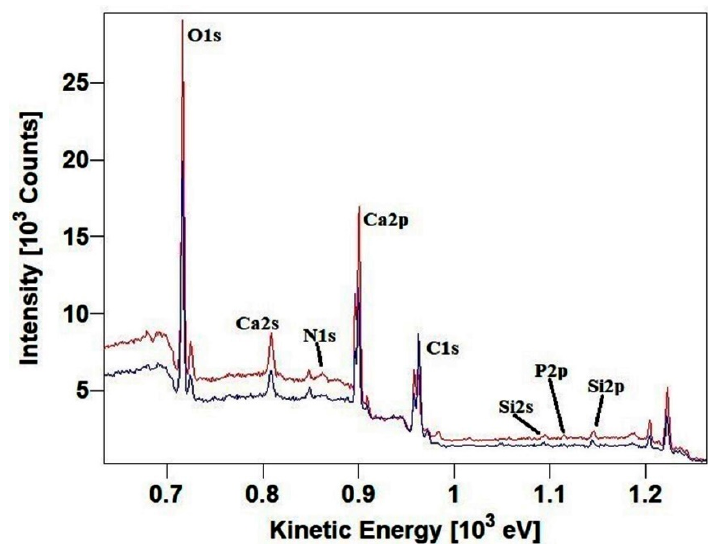
Figure 3. Wide spectra of the samples of the horizontal wall of the hypogeum: pre-(blue) and post-(red) application of glycoalkaloids extract.